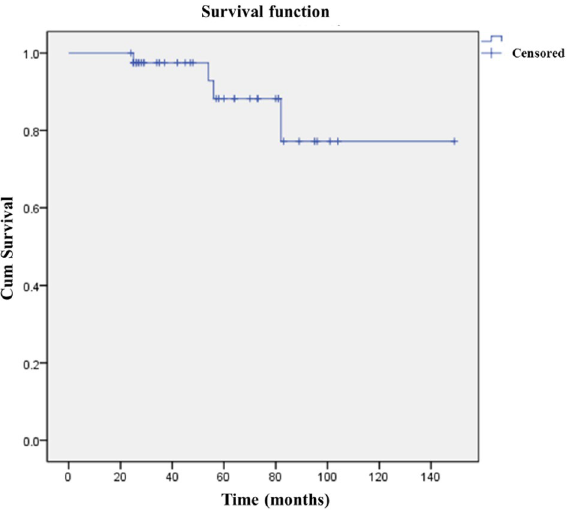
Figure 6. The survival curve of the prosthesis showed that the overall 5-year survival rate of prosthesis was 88.2% and the mean survival time of prosthesis was 129.8 (95% CI 111.9–147.7)